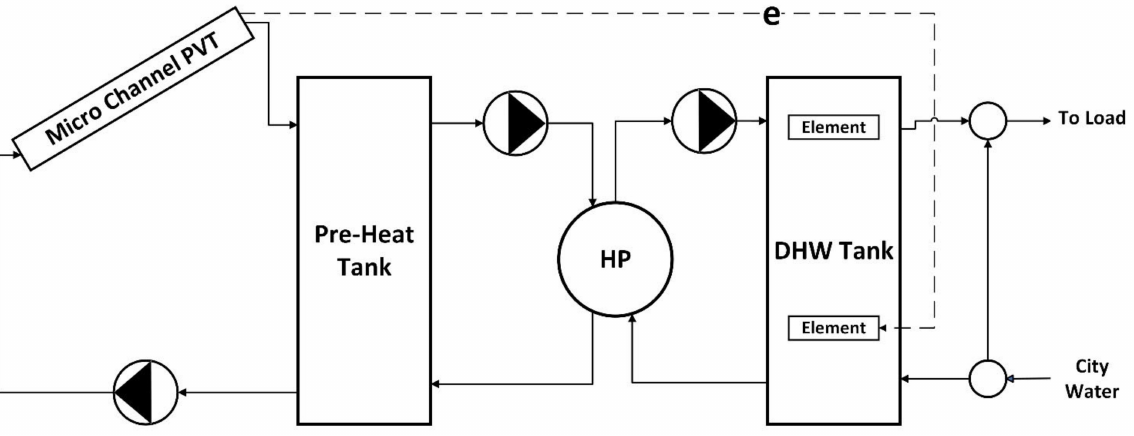
Figure 4. Schematic of MCPVT-HP.